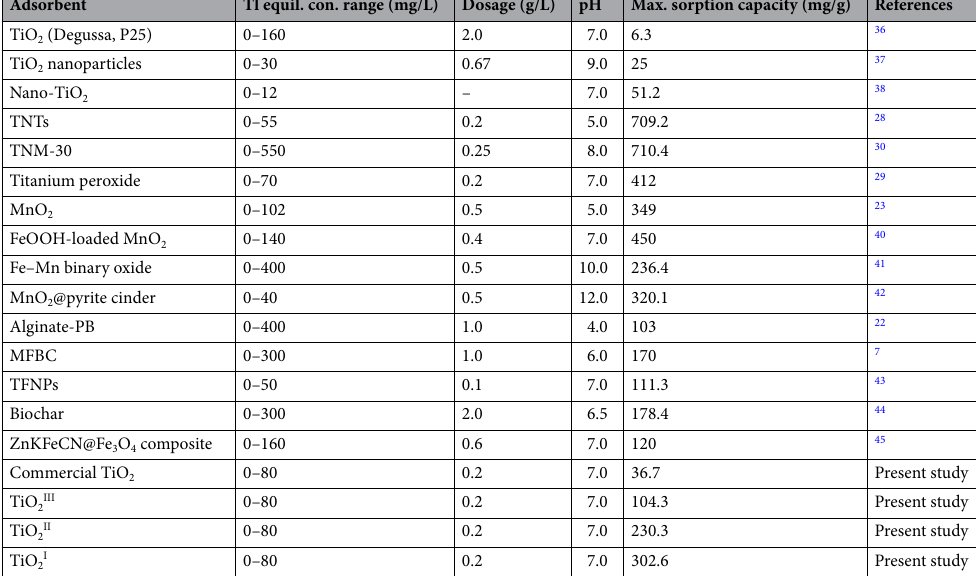
Adsorbent Tl equil. con. range (mg/L) Dosage (g/L) pH